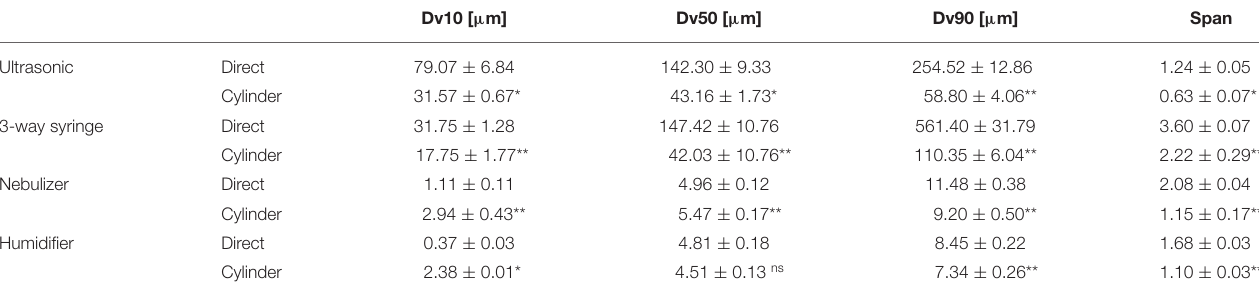
TABLE 1 | Numerical parameters of droplet size distribution in aerosols between direct spraying group and through-cylinder